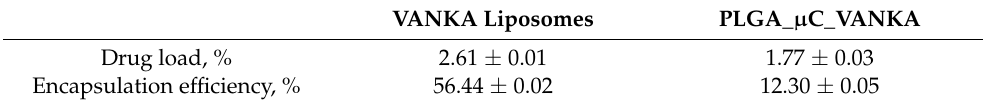
Table 4. Drug loading and encapsulation efficiency of liposomes and